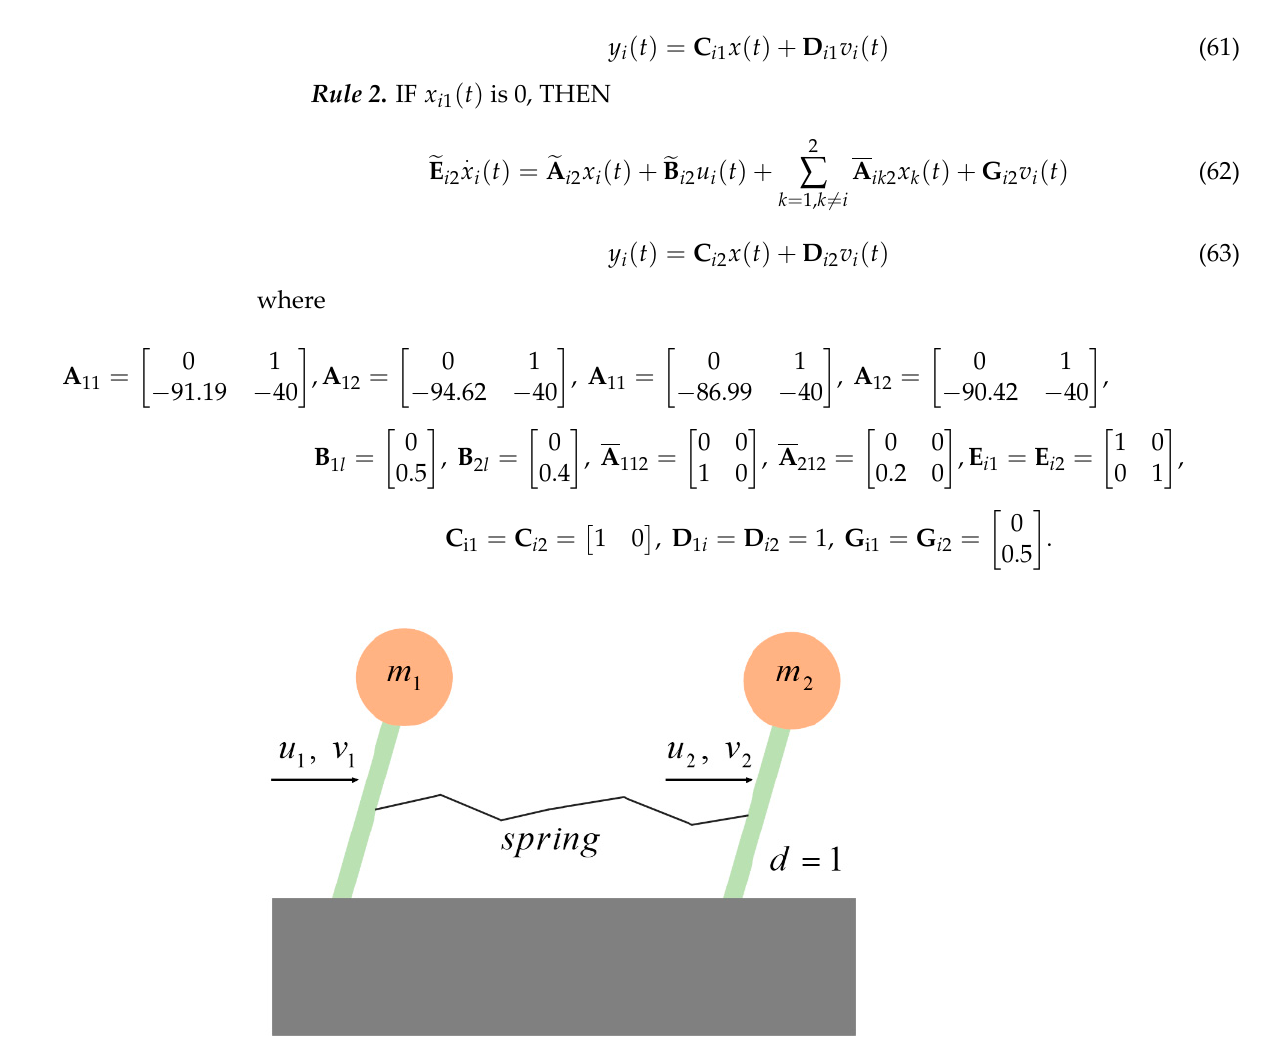
Figure 7. Double-inverted pendulum system. Figure 7. Double‑inverted pendulum system.